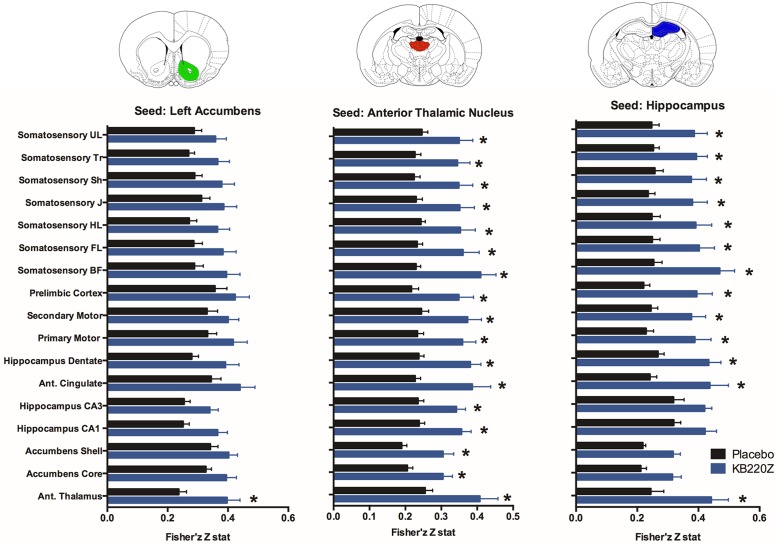
Resting state functional connectivity is higher with KB220Z than with placebo.Plots show differences in functional connectivity between various ROI and three seed regions. Data are presented as mean correlation (z transformed) ± standard error. * Significantly different than placebo t221 > 2.1 p < 0.05 (p values FDR corrected at q = 0.05).